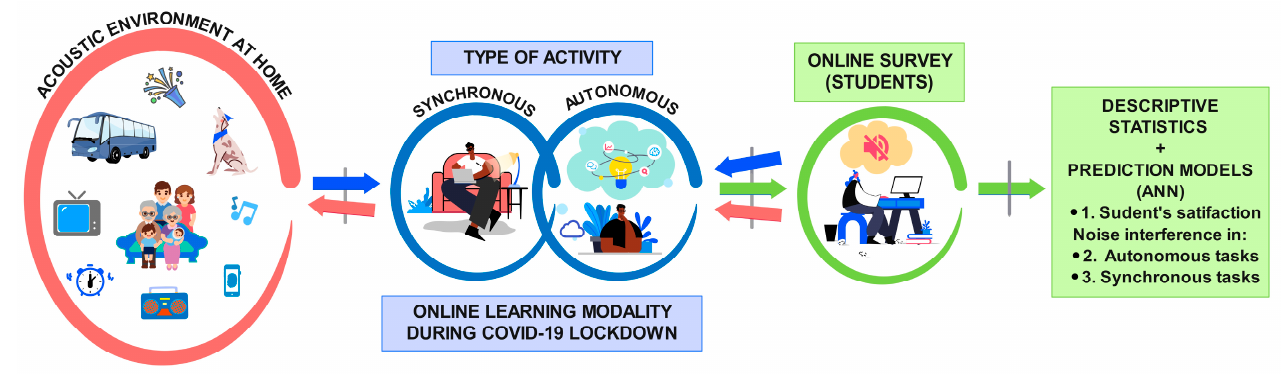
Figure 1. Conceptual scheme of the workflow followed in the present